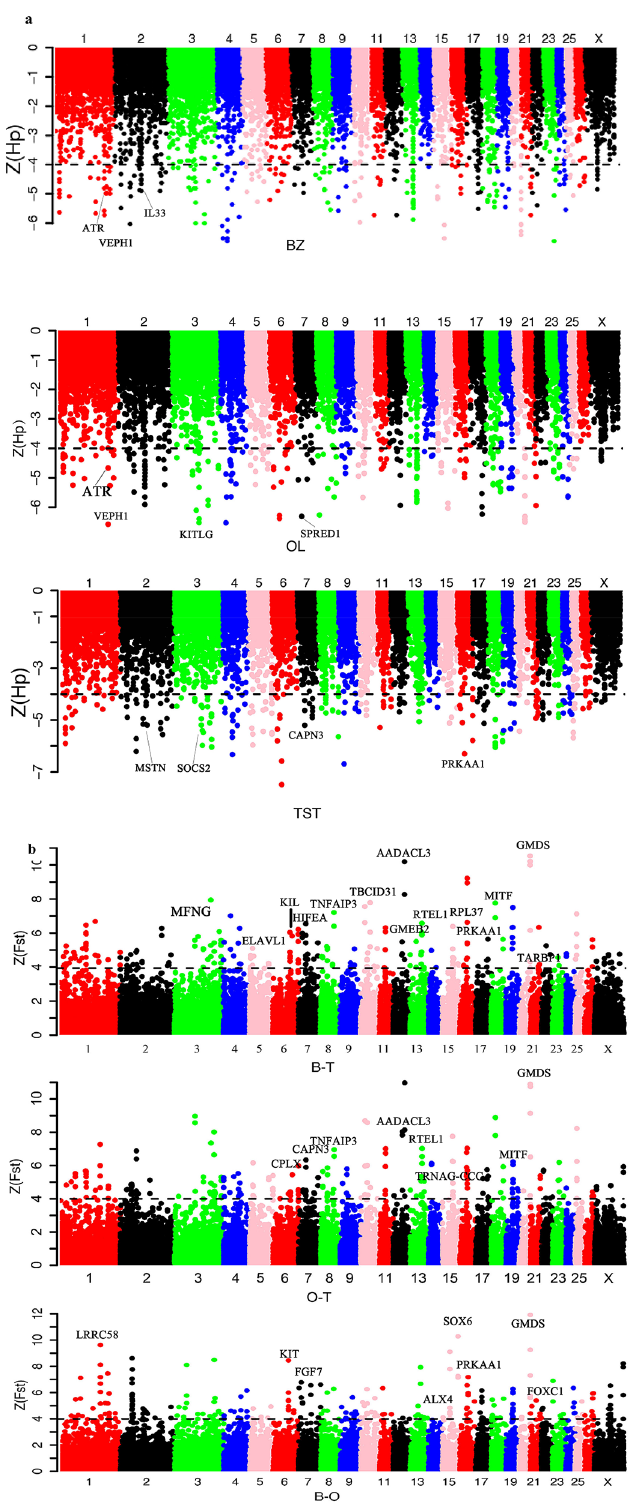
Figure 4. Analysis of the signatures of positive selection in the genome of samples. Genomic landscape of the ( a ) ZHP values and ( b ) ZF ST